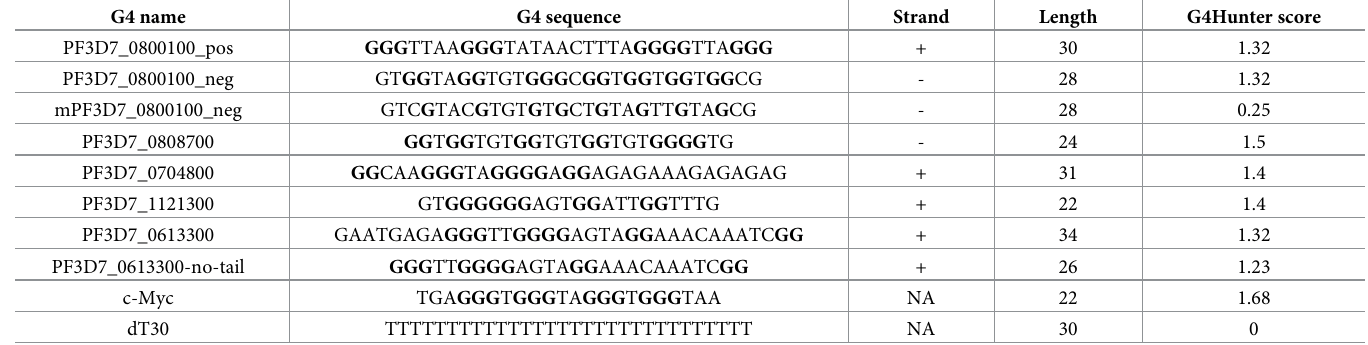
Table 3. Sequence of G4 oligonucleotides used in this study, with the strand position and the G4Hunter score. The two oligonucleotides c-Myc and dT30 were used as positive and negative controls, respectively, for ThT